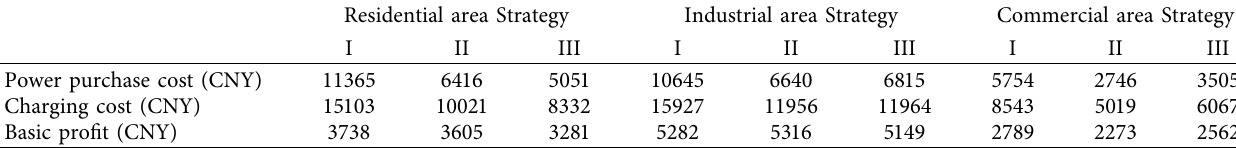
Table 8: Charging cost and power purchase cost of diferent functional areas under diferent DR